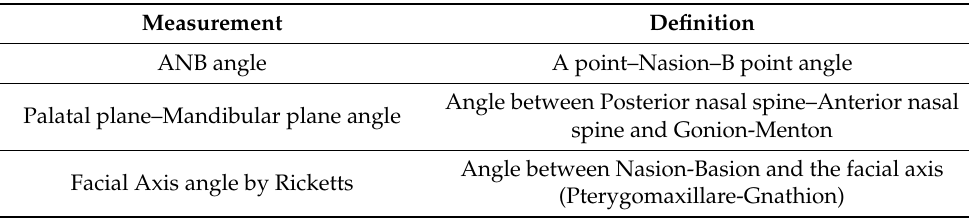
Table 2. Definitions of cephalometric measurements used in this